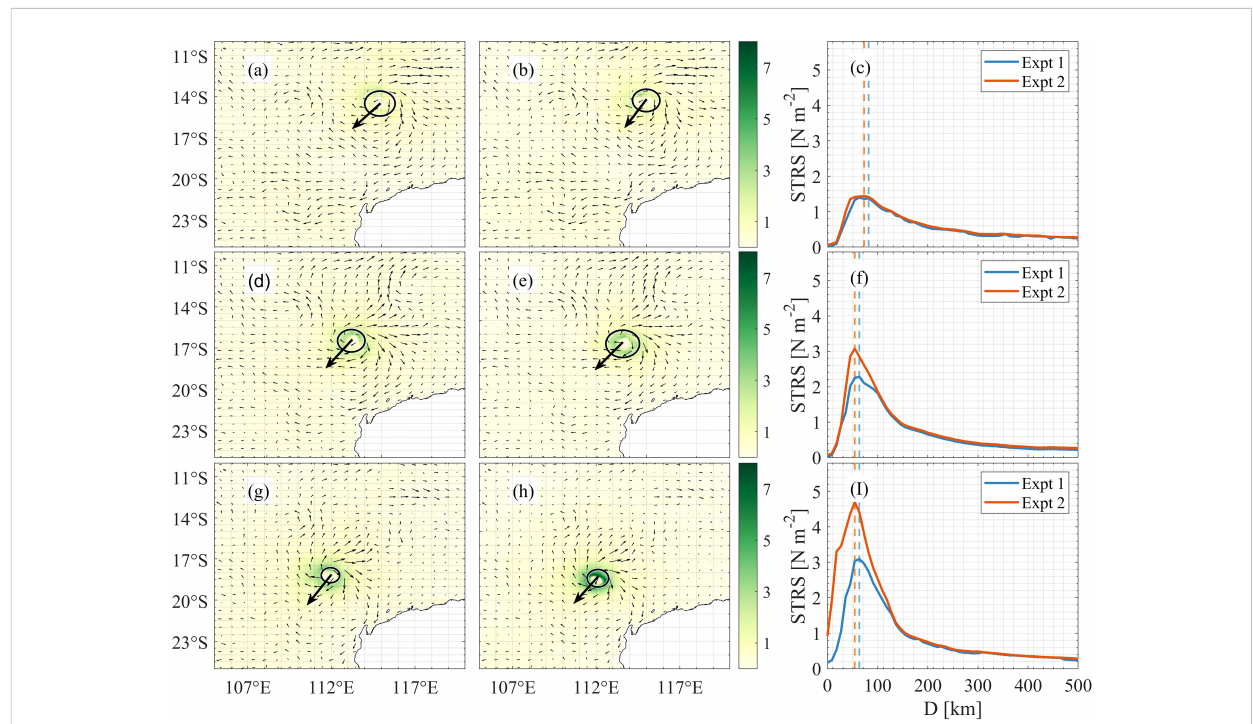
FIGURE 6 (A, D, G) are ocean surface stress without the spume scheme on 10 – 12 January 2013. (B, E, H) are the same as (A, D, G) but with the spume scheme. (C, F, I) represent the azimuthal averages of surface stress. The direction in which TC Narelle is moving forward at different times is demonstrated by the red arrows. The vectors are the directions of the local currents. The azimuthal maximum of the surface stress is shown by solid lines. The radius of maximum wind is represented by solid circles and dashed lines in spatial distributions and azimuthal averages, respectively.